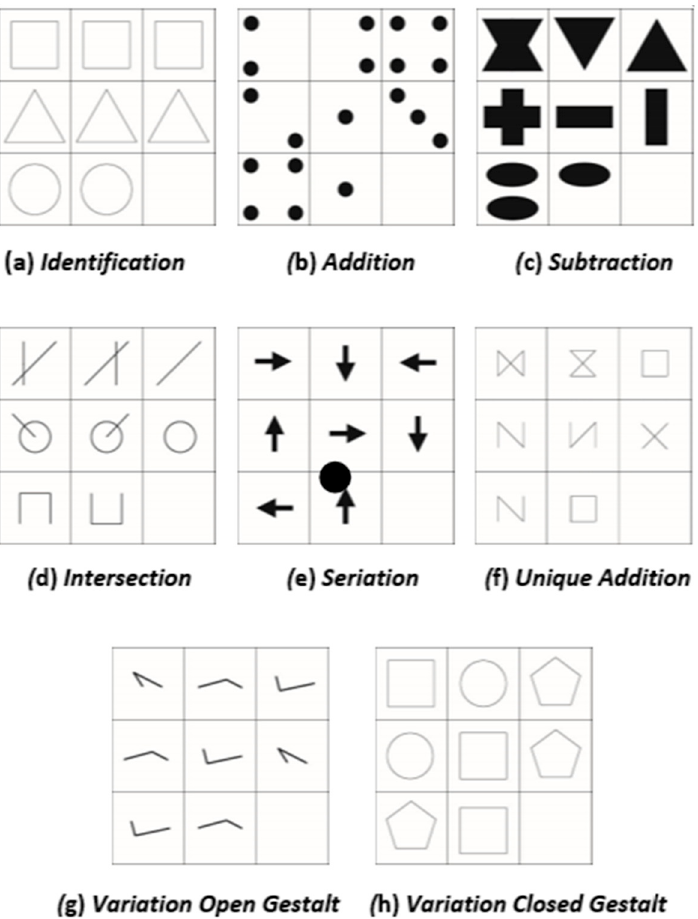
Figure 2. Overview of the eight operations that are used to construct the items. See (Hornke and Habon 1986, p. 33) for a similar example.